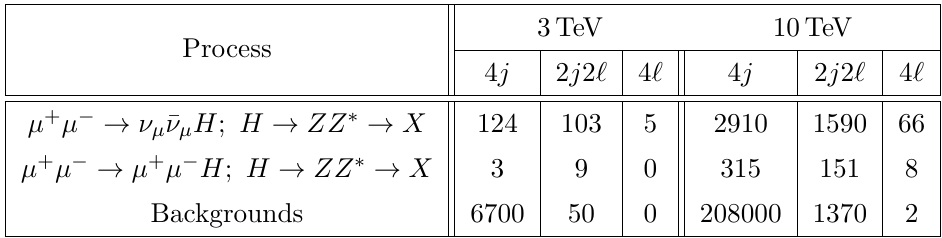
Table 4 . Total number of events for WW/ZZ -fusion H → ZZ ∗ → X and combined backgrounds after all analysis cuts discussed in the text, where X is one of 4 j , 2 j 2 ‘ , or 4 ‘